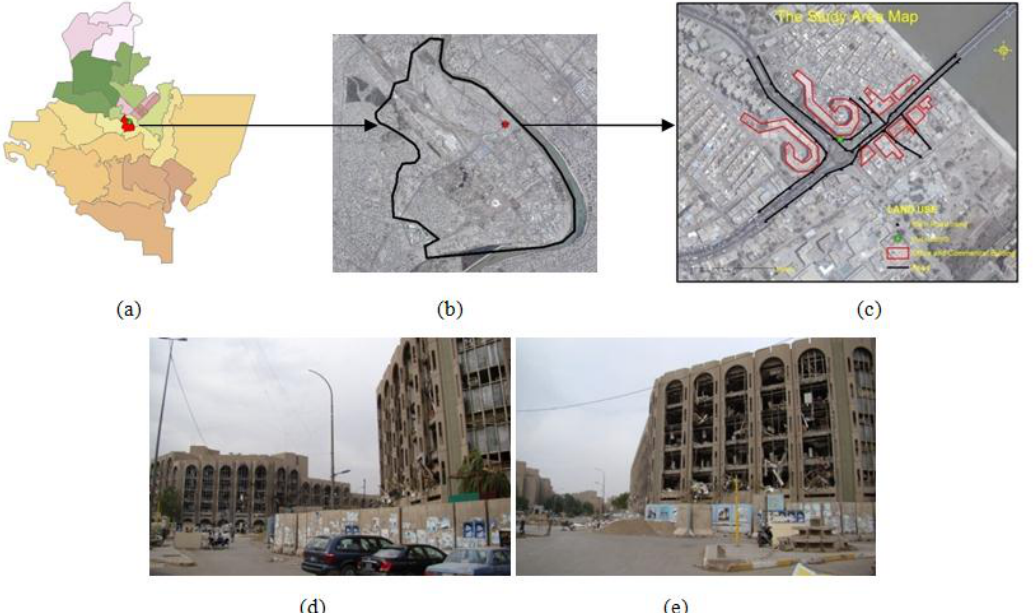
Fig.1: (a) Baghdad city capital of Iraq, (b) Al - Karkh district centre of Baghdad, and the star red represent truck Bomb Explosion, (c) Illustration the study area is sample contain building congregation (official, commercial, and inhabitants) in red color, The main road in black line, The star green represent truck bomb, and (d) (e) building target